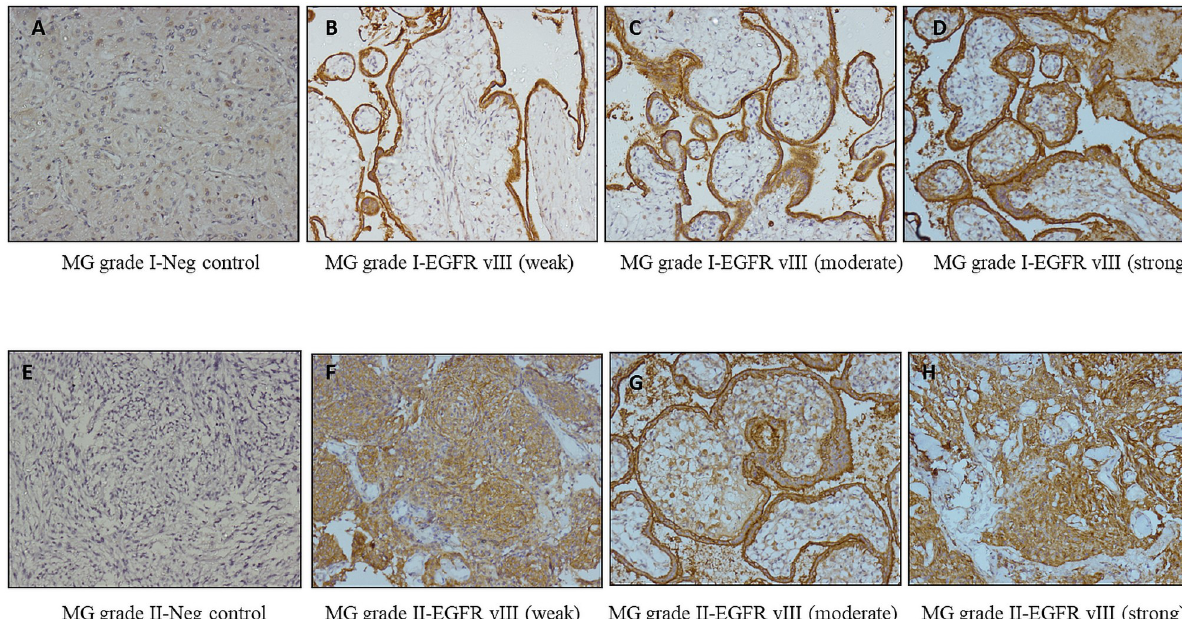
Fig 3. These figures show intensity scores of immunohistochemical staining (A) Meningioma stained with anti-EGFR showing negative staining in meningioma grade I (B) 1+ weak staining (C) 2+ moderate staining (D) 3+ strong staining (E) Meningioma stained with anti-EGFR showing negative staining in meningioma grade II (F) 1+ weak staining (G) 2+ moderate staining (H) 3+ strong staining. Original magnification for all images was 40 × . Images are arranged as follows, on the left side (A) , (B) , (C), and (D) are of MG grade I. On the right side (E) , (F) , (G), and (H) belongs to meningioma grade